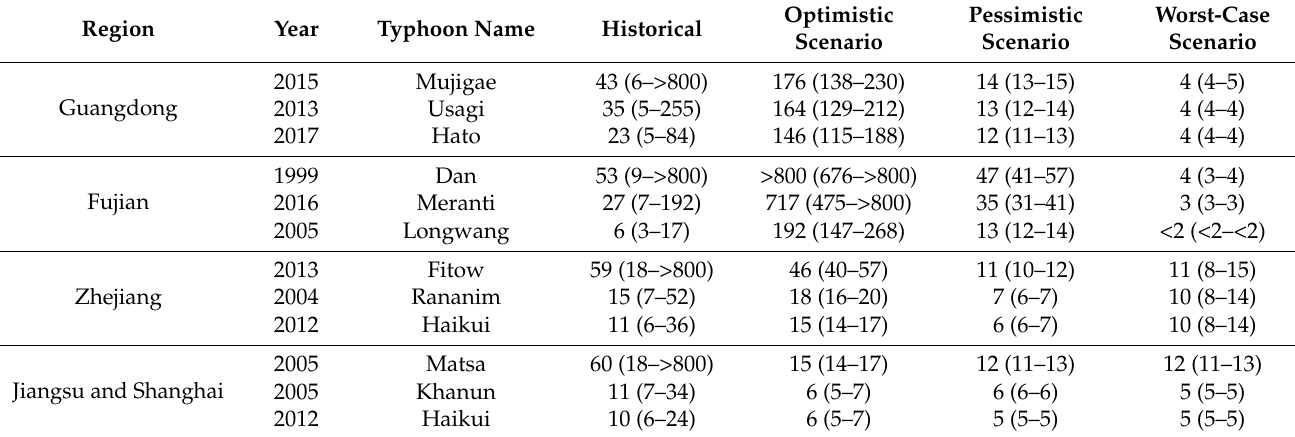
Table 3. Estimated return period (in years) for the top three highest impact events for the respective regions derived from Figure 7. The numbers in the bracket indicate the lower and upper bounds of the uncertainty range. Region